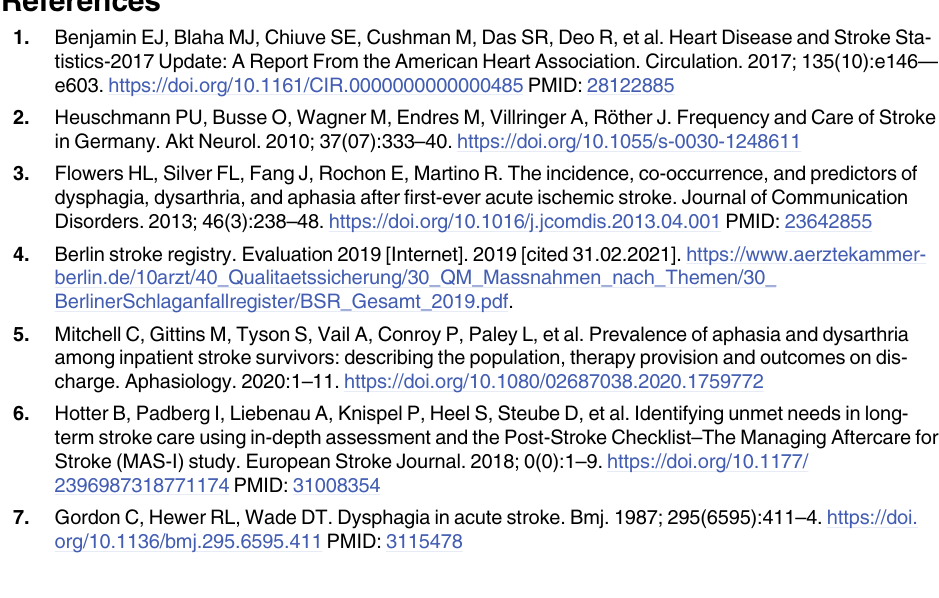
S1 Table. Overview of guidelines included in the parameter